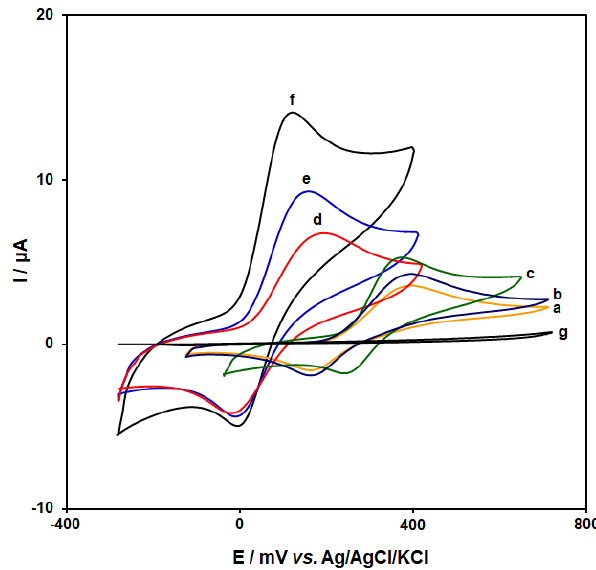
Figure 6. Cyclic voltammograms captured for the redox reaction of DA (150.0 μM) in PBS (0.1 M; pH = 7.0) on bare CPE ( curve a ), CoMOF/CPE ( curve b ), 1-M,3-BB/CPE ( curve c ), GO/CPE ( curve d ), CoMOF-GO/CPE ( curve e ), and CoMOF-GO/1-M,3-BB/CPE ( curve f ). Moreover, curve g shows the CoMOF-GO/1-M,3-BB/CPE in PBS (0.1 M; pH = 7.0). In all cases, the scan rate was 50 mV/s. Table 1. Comparison of the electrochemical oxidation of DA (150.0 μM) in PBS (0.1 M; pH = 7.0) on the surface of various electrodes.